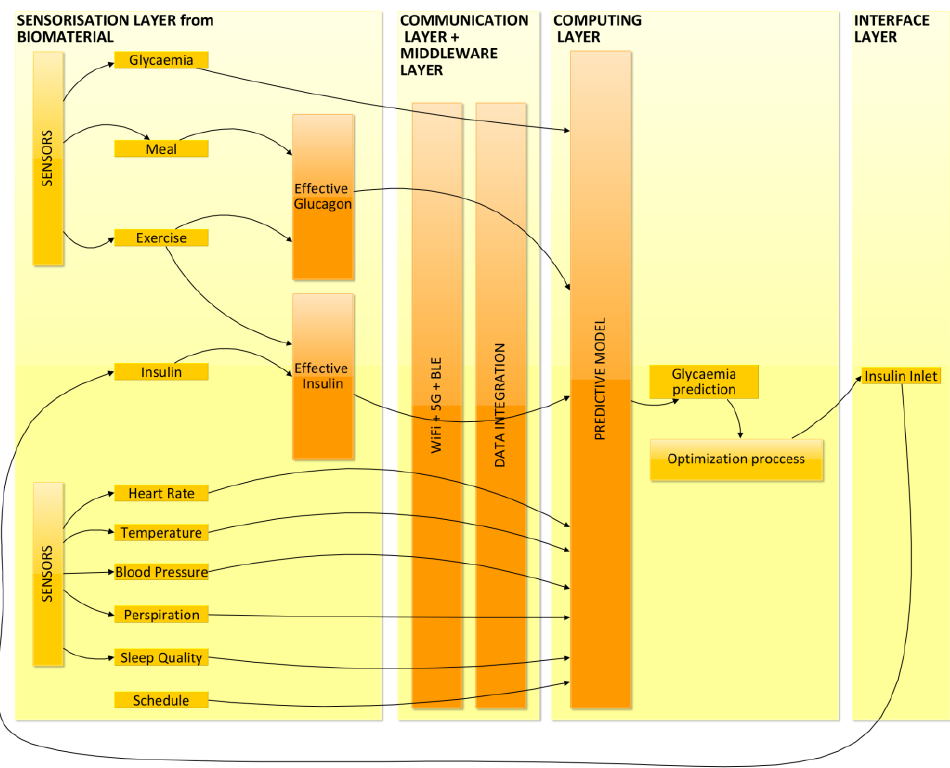
Figure 3. Flow of data to the predictive model.